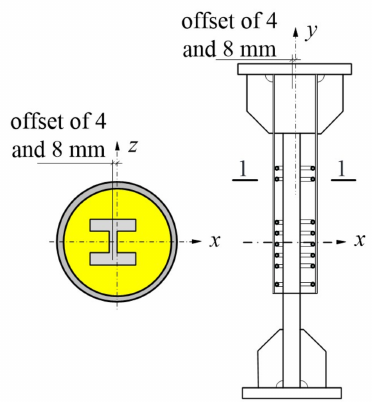
Figure 20. O ff set of profile steel from the z